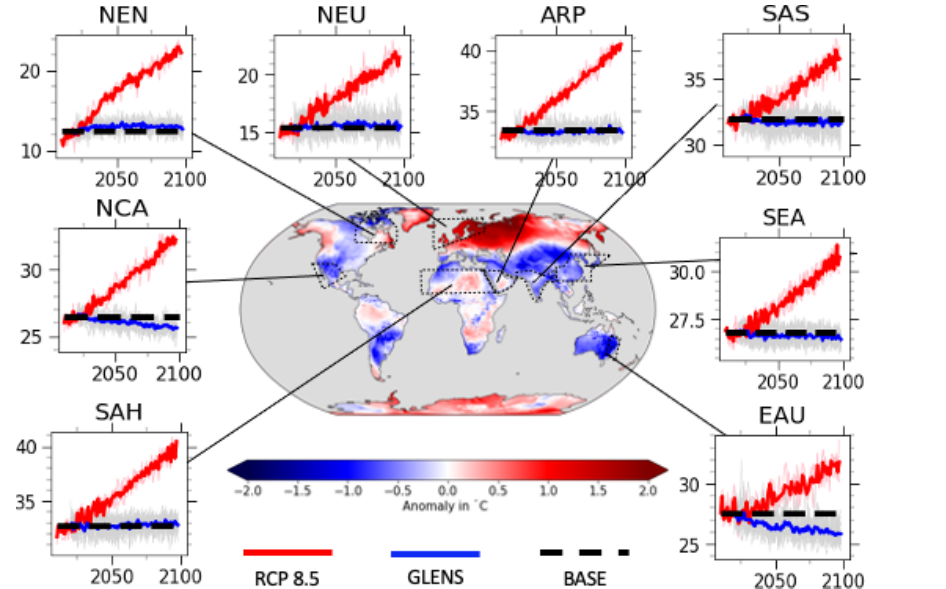
Figure 5. Ensemble mean of projected changes in mean global temperature for GLENS EC (2075–2095) minus BASE (2010–2030) with inset regional time series of the warmest night (TNx) for northeastern North America (NEN), northern Central America (NCA), Sahara (SAH), northern Europe (NEU), Arabian Peninsula (ARP), South Asia (SAS), East Asia (EAS), and eastern Australia (EAU). Regional time series comprise ensemble mean TNx for GLENS EC minus BASE in thick blue and individual members in light gray, ensemble mean TNx for RCP8.5 EC in thick red and individual members in light pink, and ensemble and climatological mean TNx for BASE in thick dashed